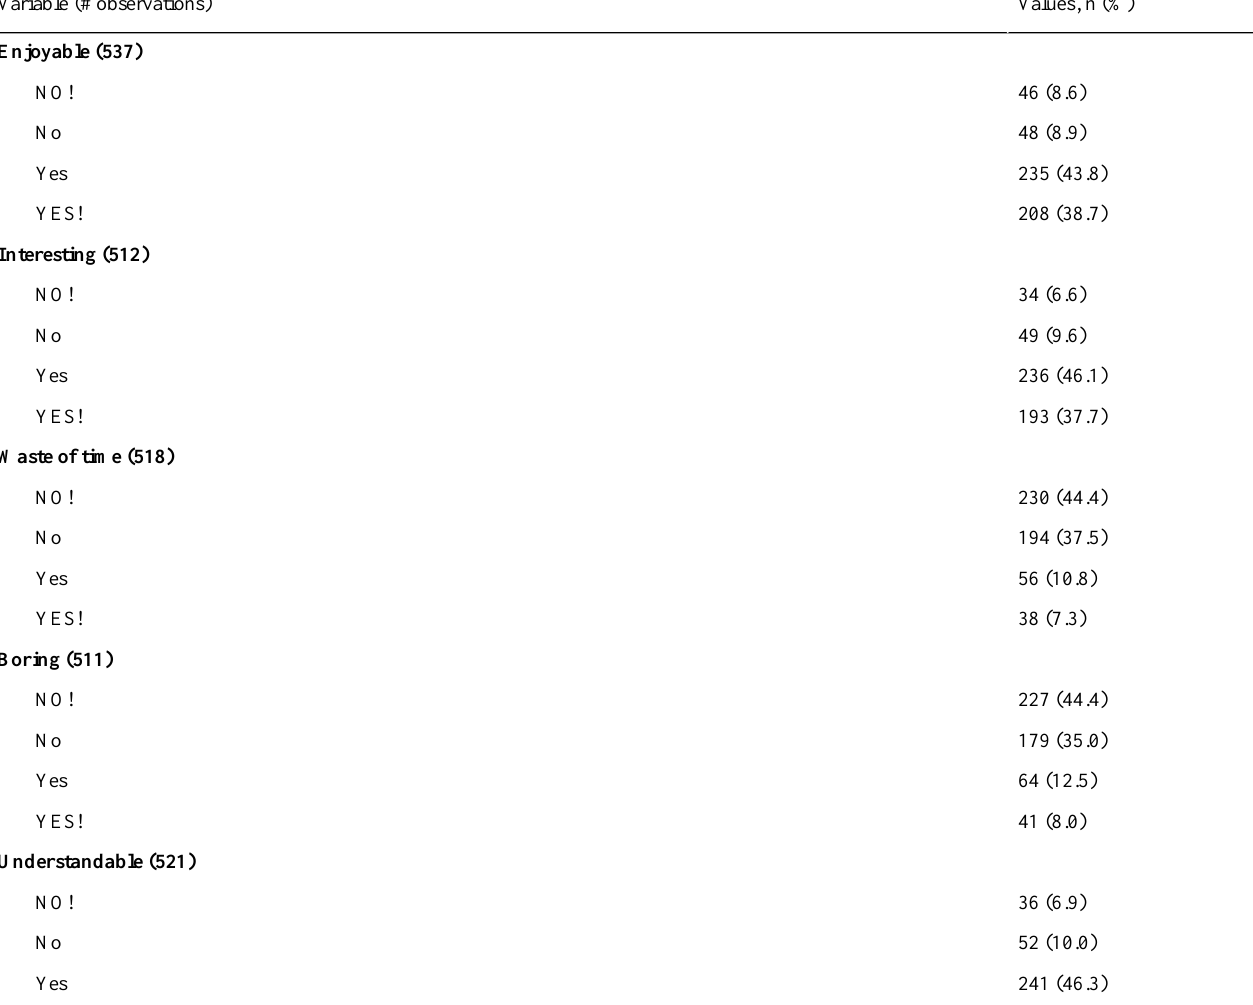
Table 4. Perceptions of ACT Out! intervention. (Percentages may not add exactly to 100 due to